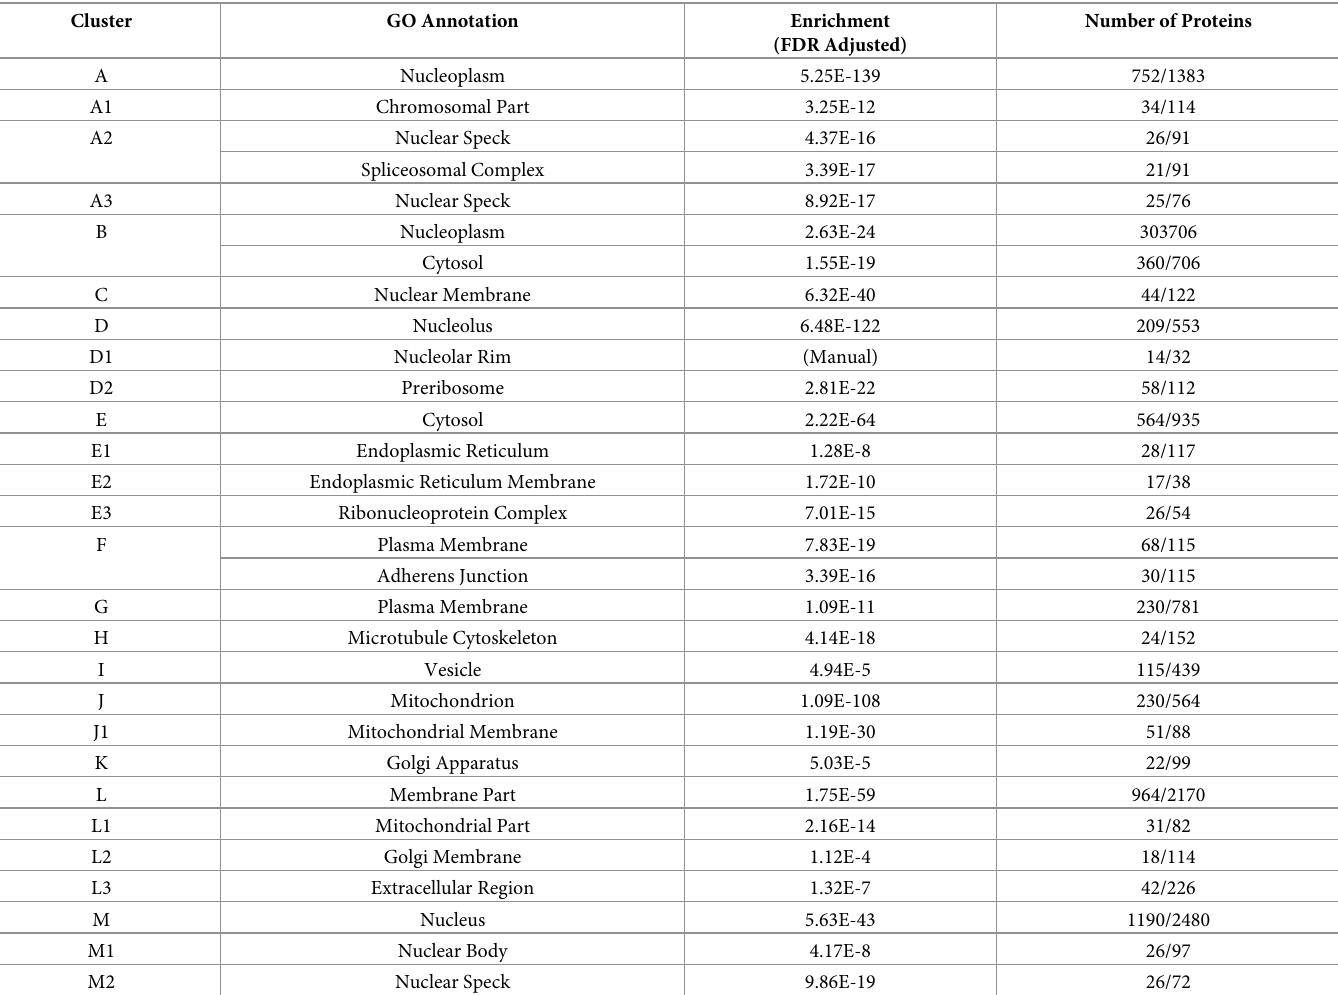
Table 3. Enrichments for clusters identified in Fig